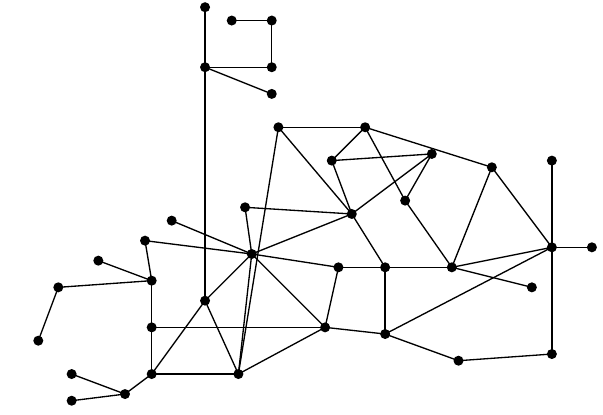
Figure 3. Graph from Barcelona DWN.